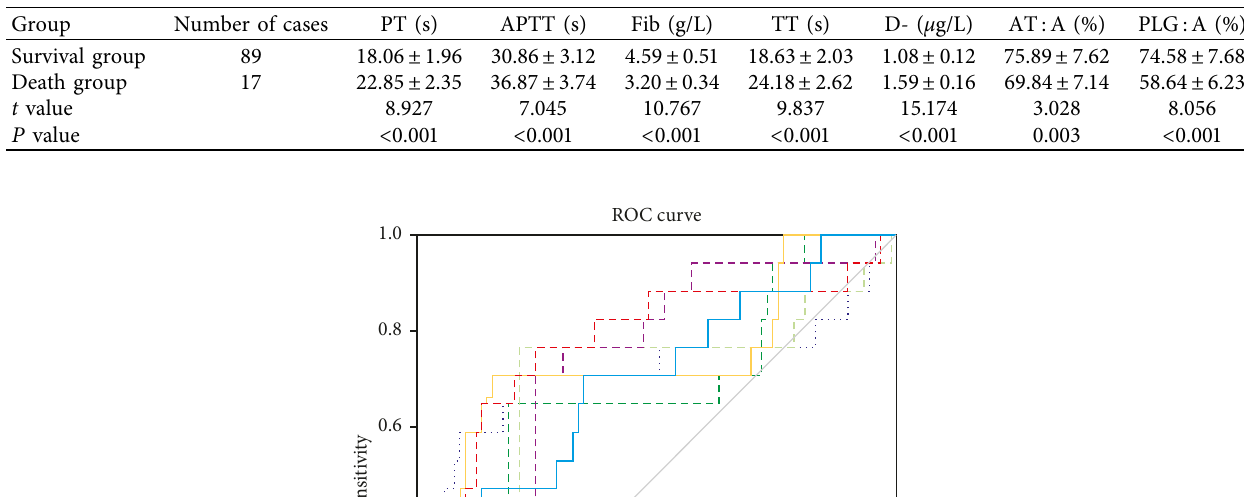
Table 3: Serum coagulation and fibrinolysis indexes of death group and survival group ( X